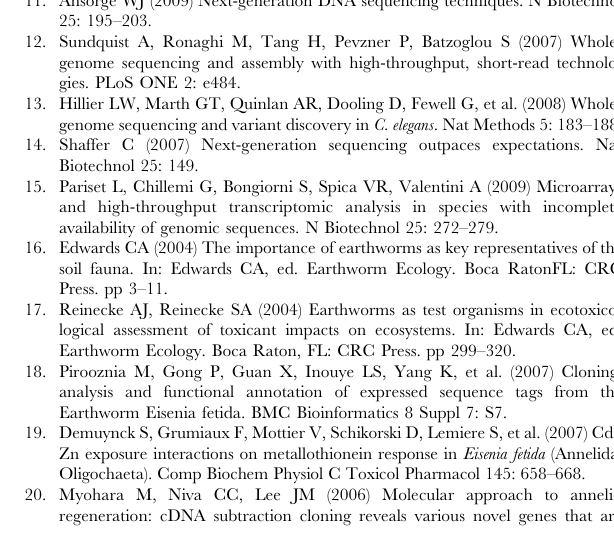
Table S3 Validated oligo probes and their target sequences. Name and sequence of validated 60-mer and 40-mer probes and their target ESTs, as well as their length and hybridization signal intensity (mean and coefficient of variance). Table S4 Annotation of validated target ESTs. Annotation information obtained for the 65,365 positive target ESTs (before removing highly similar 60-mer probe sequences), which includes query results from BLASTN, BLASTX, InterProScan and